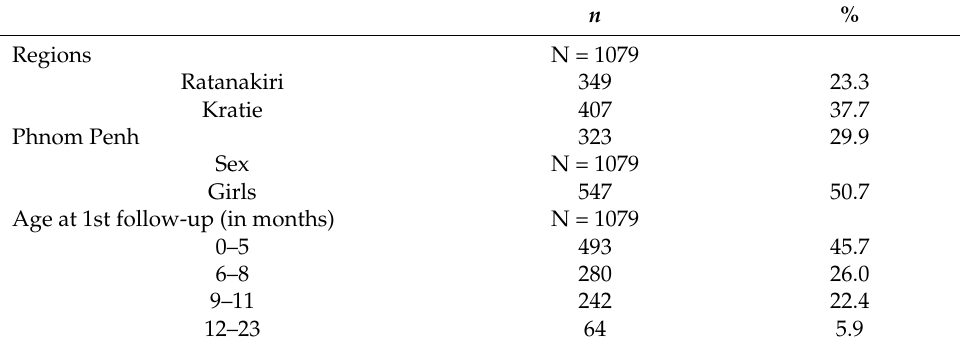
Table 3. Background characteristics of participants at 1st